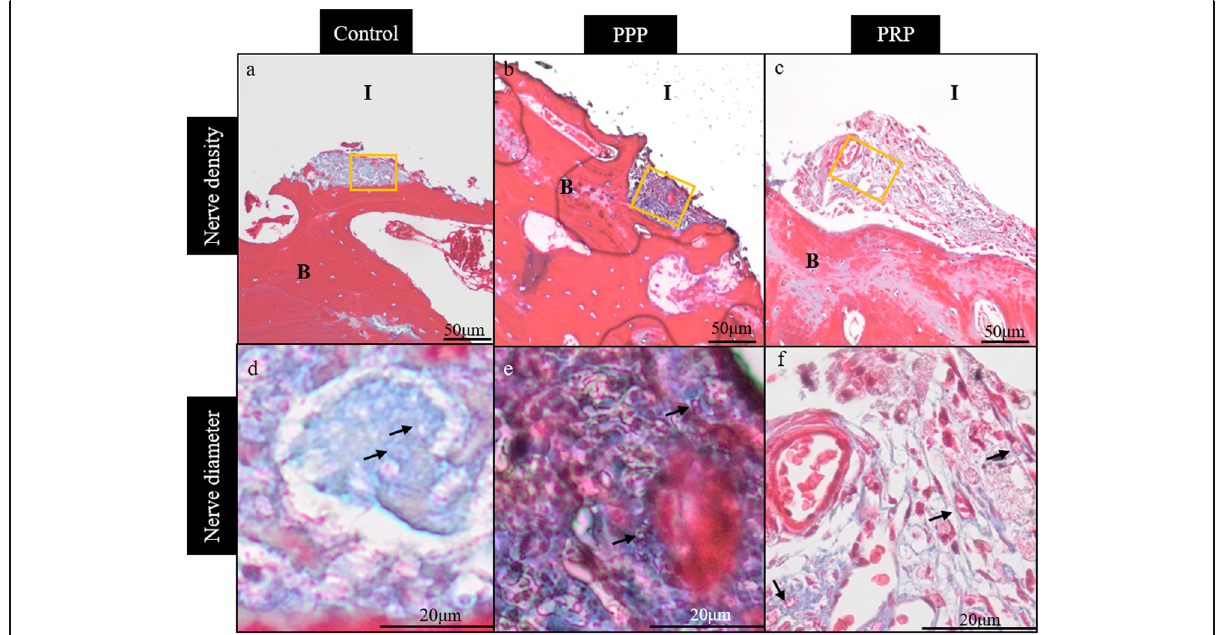
Fig. 3 Histological sections stained with Massons ’ s trichrome stain for control ( a , d ), platelet-poor plasma ( b , e ), platelet-rich plasma ( c , f ) group near the implant surface. No difference was observed in the myelinated nerve density between the three groups (upper row). The nerve fiber diameter in the PRP group was greater than in the control and PPP group (see arrows, bottom row). All sections derive from 6 months healing time and taken with a light microscope at × 20 (upper row) or × 40 magnification (bottom row). I, implant; B,